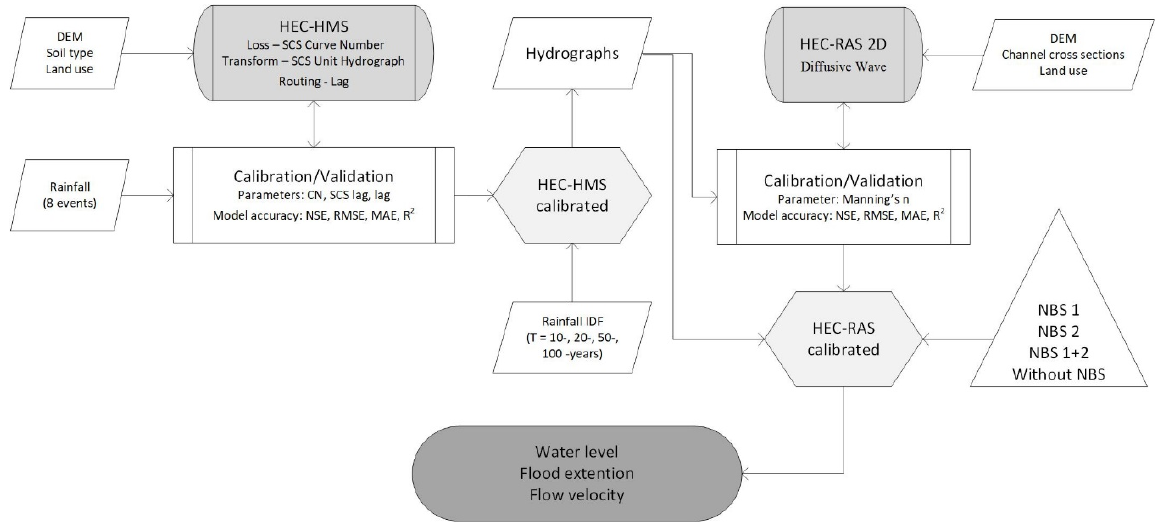
Figure 2. Flowchart of the methodology used to derive flood hazard in the Ribeira dos Covões catchment, including data inputs, main calculation methods used within the Hydrologic Engineering Center (HEC)-Hydrologic Modelling System (HMS) and hydraulic HEC-River Analysis System (RAS) models, and list of parameters used for model calibration and validation.